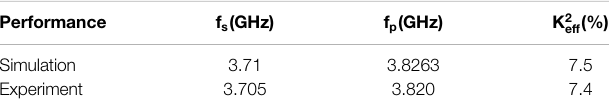
TABLE 3 | Performance comparison between experimental and simulated results of the FBAR. Performance